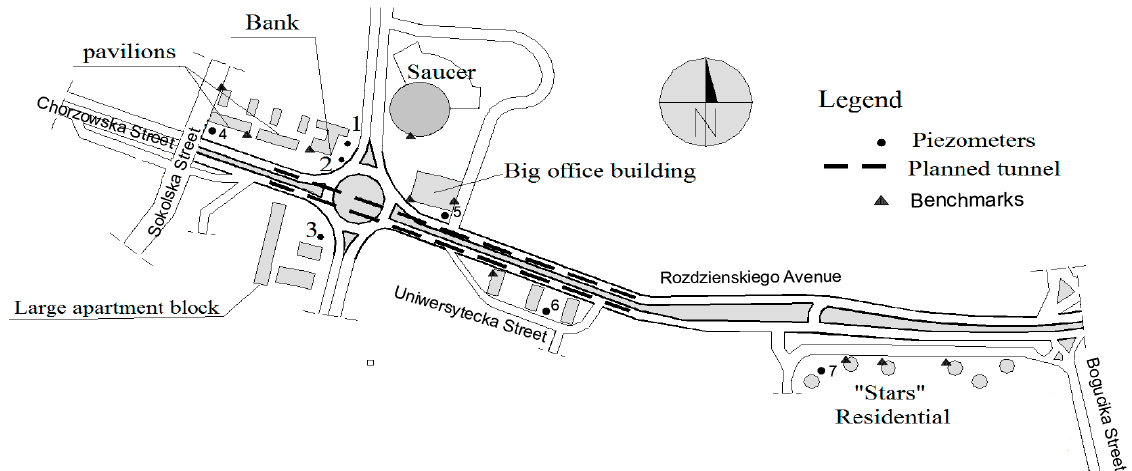
Appl. Sci. 2021 , 21 , x FOR PEER REVIEW Figure 4. Schematic of the tunnel under the roundabout in Katowice.